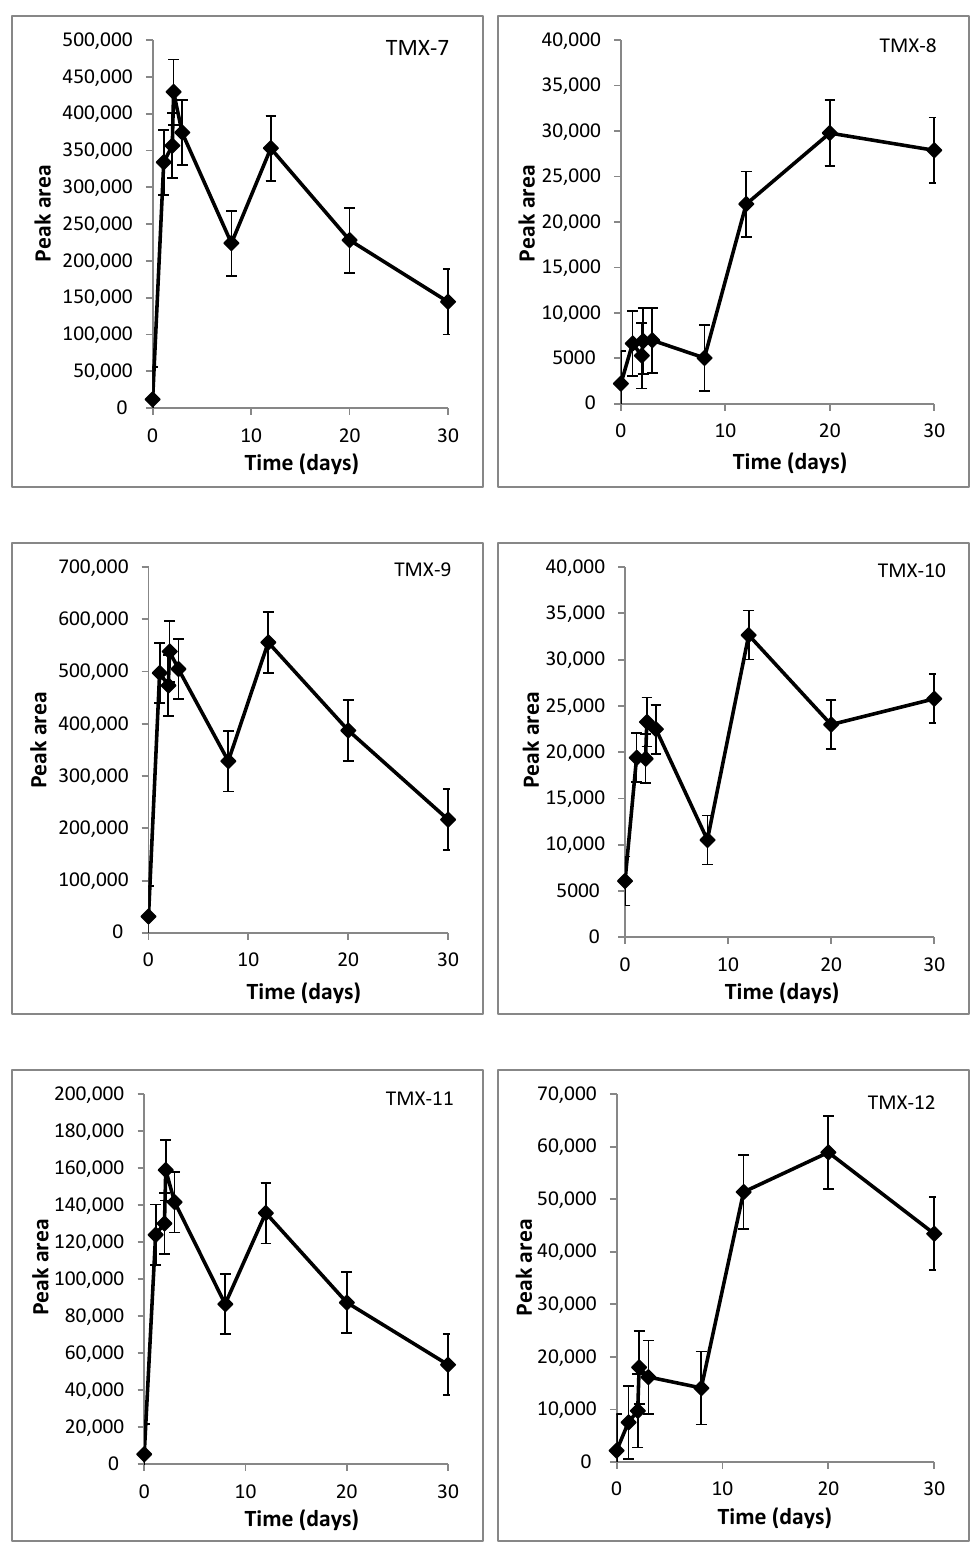
Figure 4. Peak area formation of the intermediate metabolites TMX-1–TMX-12 during TMX degradation as the sole carbon source by L. portucalensis F11 in function of time.